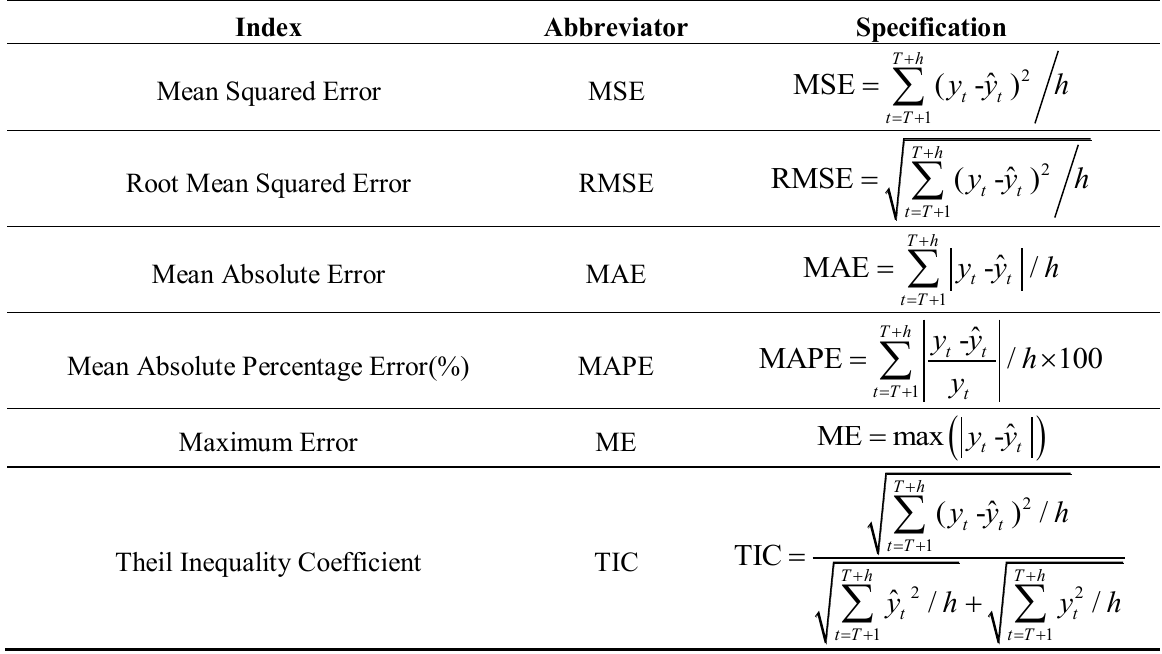
Table 1. Traditional evaluation